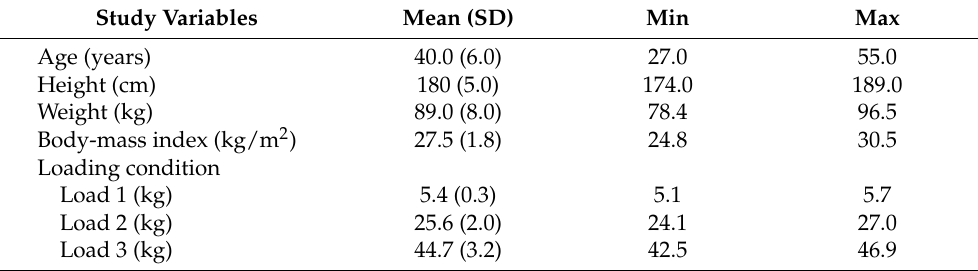
Table 1. Basic descriptive statistics of the study participants ( n =